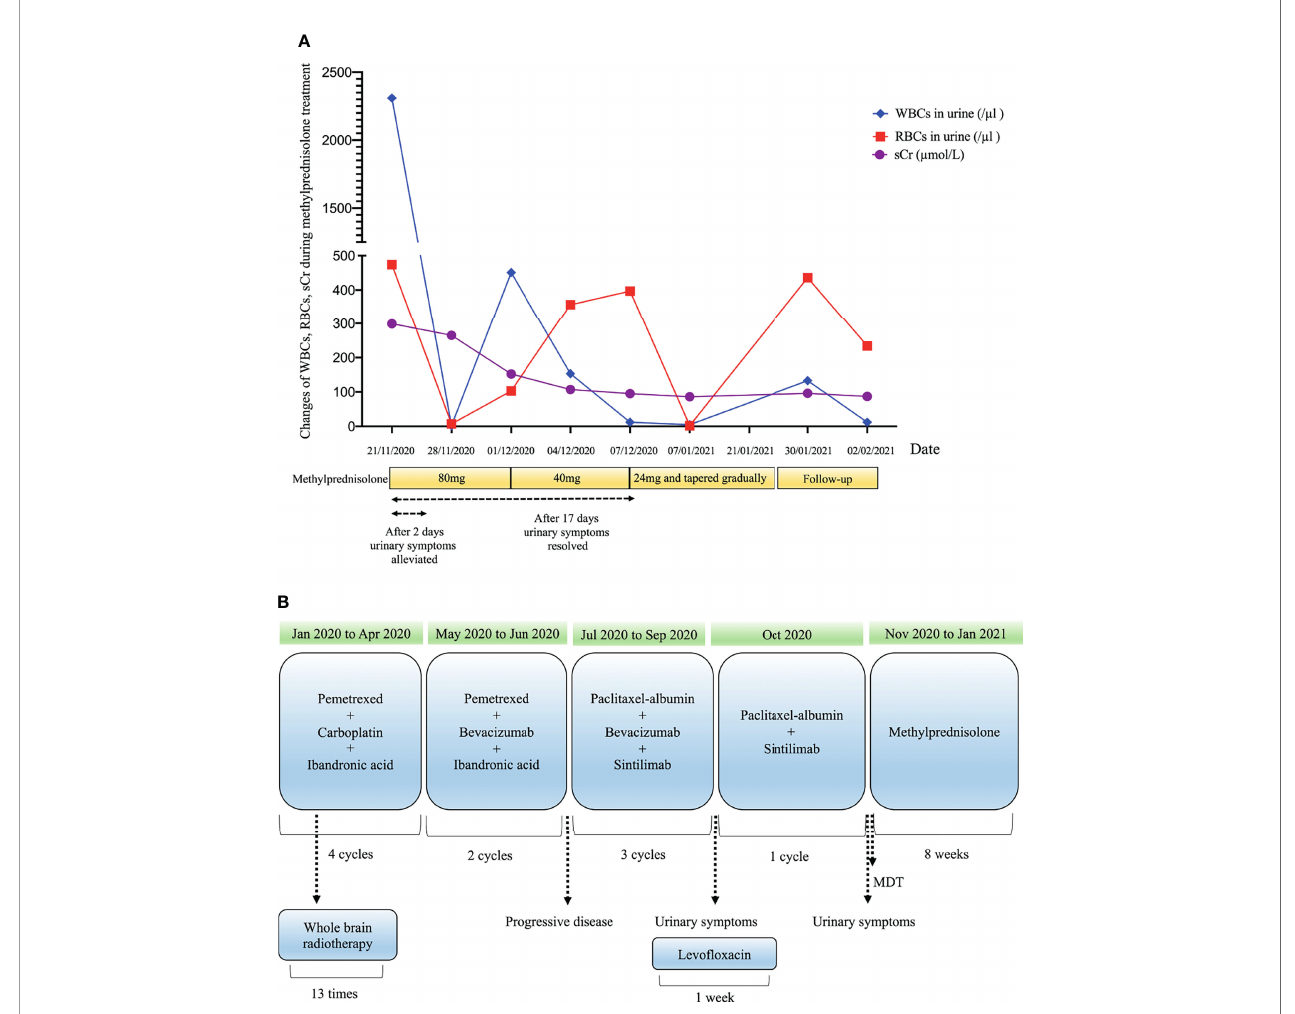
FIGURE 2 | Clinical course over methylprednisolone therapy (A) and timeline of treatment course (B) . Drug dosage: bevacizumab, 7.5mg/kg; carboplatin, (area under the concentration-time curve) 4-5 mg/mL/min; ibandronic acid, 4mg; levo fl oxacin, 500mg; methylprednisolone (initial), 1mg/kg/d; paclitaxel-albumin, 260mg/ m 2 ; pemetrexed, 500mg/m 2 ; sintilimab,